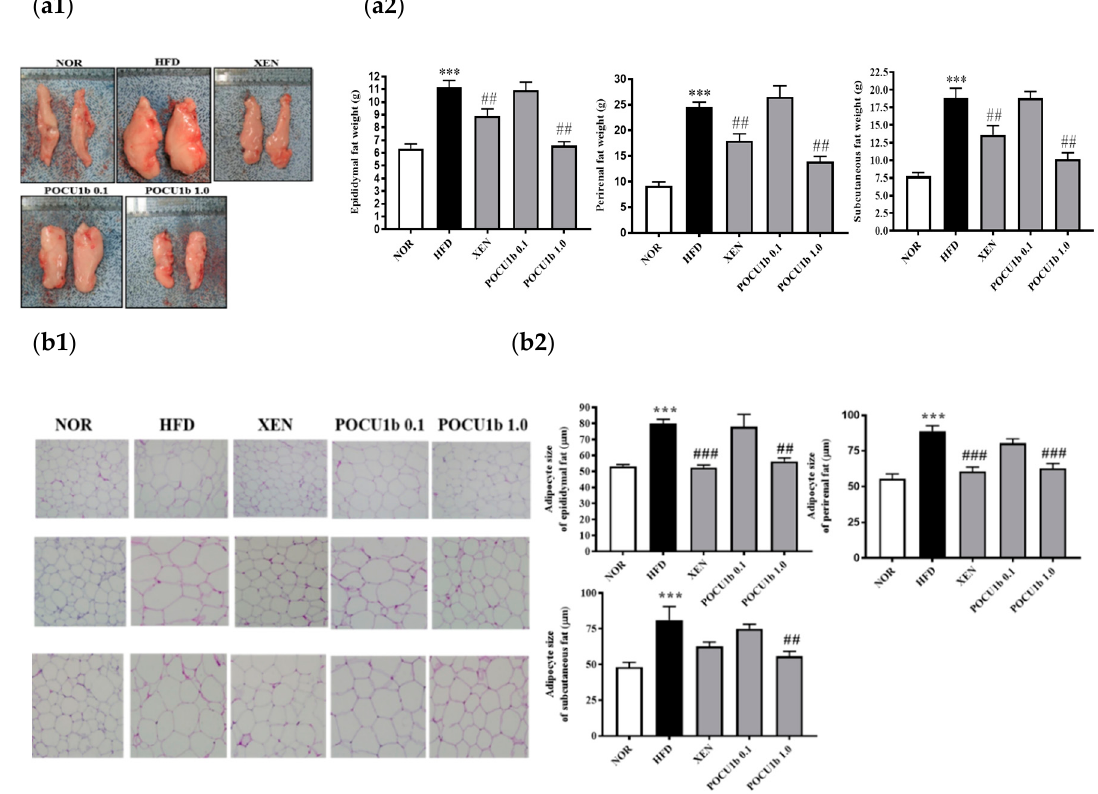
Figure4. E ff ectsofPOCU1bonfatweightandadipocytesizeinepididymal, perirenal, andsubcutaneous Figure 4. Effects of POCU1b on fat weight and adipocyte size in epididymal, perirenal, and fat tissues in HFD-fed rats. ( a1 ) Photographs of epididymal fat for all groups, ( a2 ) fat weight, ( b1 ) fat subcutaneous fat tissues in HFD ‐ fed rats. ( a1 ) Photographs of epididymal fat for all groups, ( a2 ) fat tissue morphology, and ( b2 ) adipocyte size in epididymal, perirenal, and subcutaneous fat tissues. weight, ( b 1) fat tissue morphology, and ( b 2) adipocyte size in epididymal, perirenal, and *** p < 0.001 vs. NOR, ## p < 0.01, ### p < 0.001 vs. HFD. subcutaneous fat tissues. *** p < 0.001 vs. NOR, ## p < 0.01, ### p < 0.001 vs. HFD.